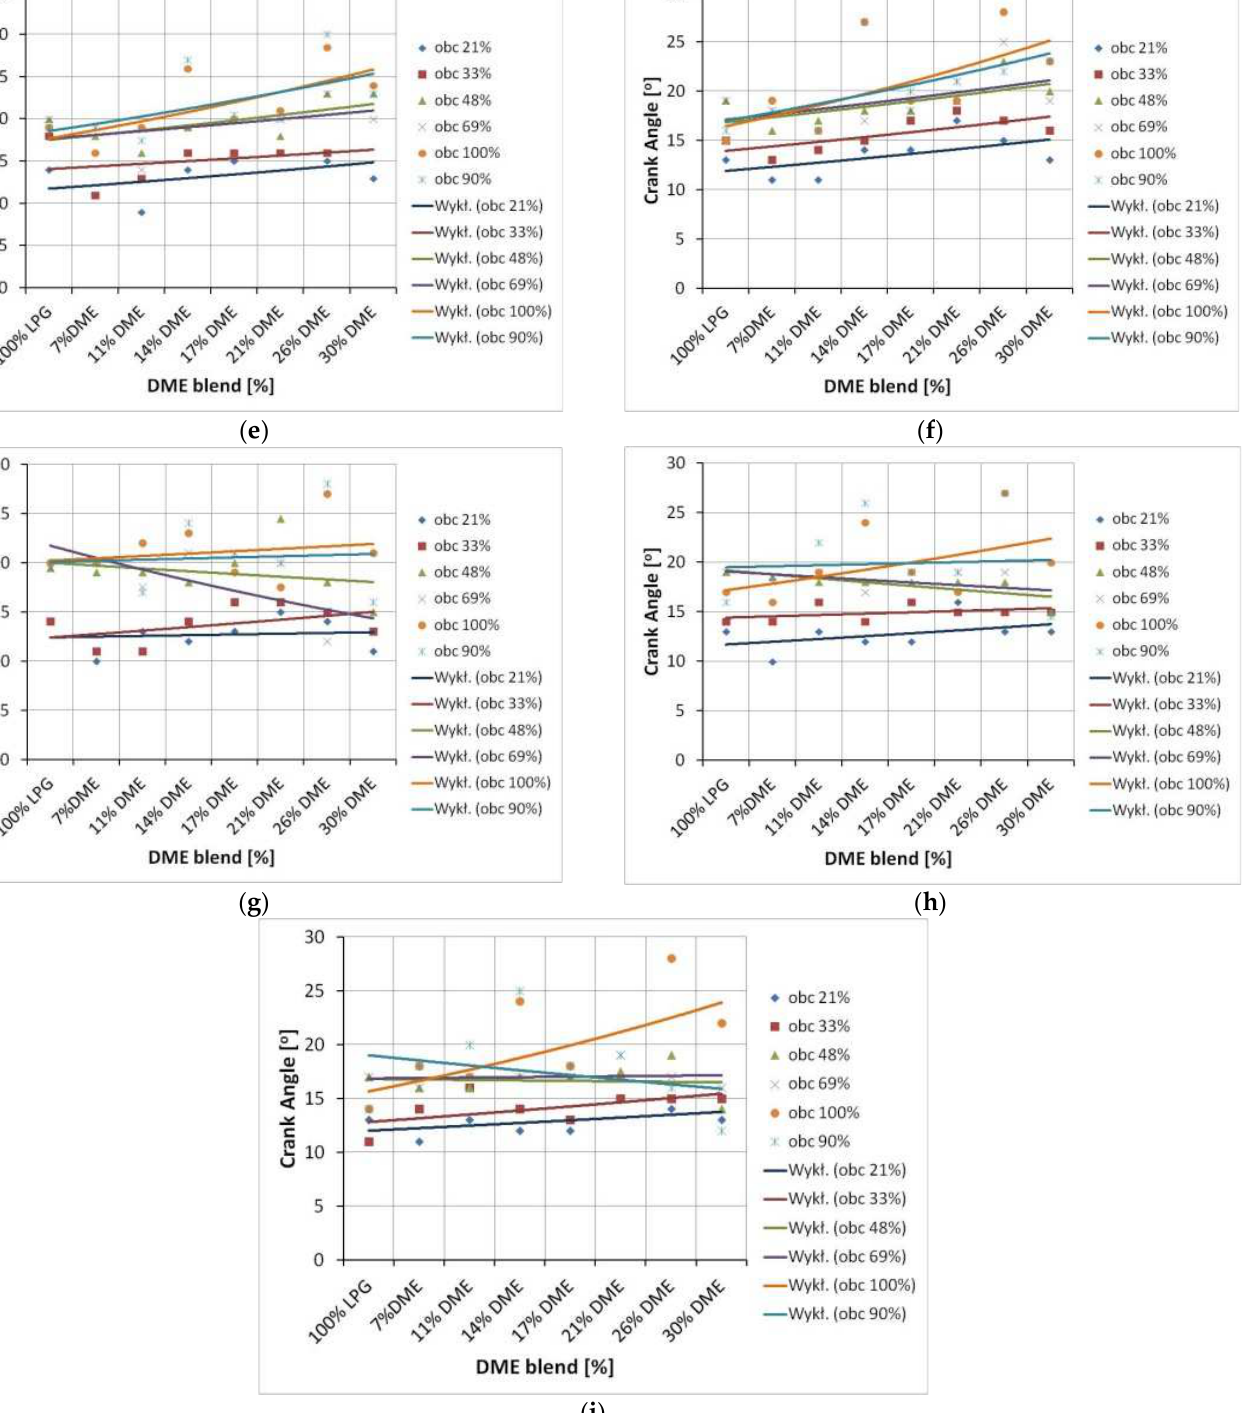
Figure 9. Shift of maximum in-cylinder pressure values relative to TDC. ( a ) 2000 rpm and 0° CA correction, ( b ) 2500 rpm and 0° CA correction, ( c ) 3000 rpm and 0° CA correction, ( d ) 2000 rpm and +3° CA correction, ( e ) 2500 rpm and +3° CA correction, ( f ) 3000 rpm and +3° CA correction, ( g ) 2000 rpm and +6° CA correction, ( h ) 2500 rpm and +6° CA correction, ( i ) 3000 rpm and +6° CA correction.